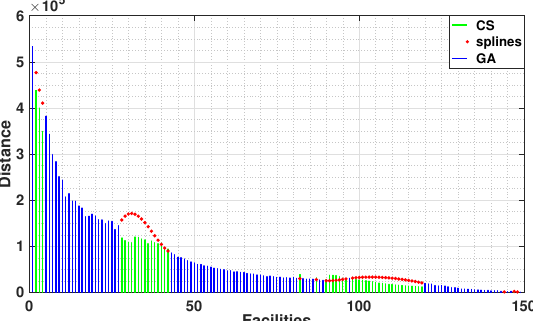
Figure 11. The Pareto set after solving the facility location problem for the London dataset using: genetic algorithms, crowdsourcing and cubic